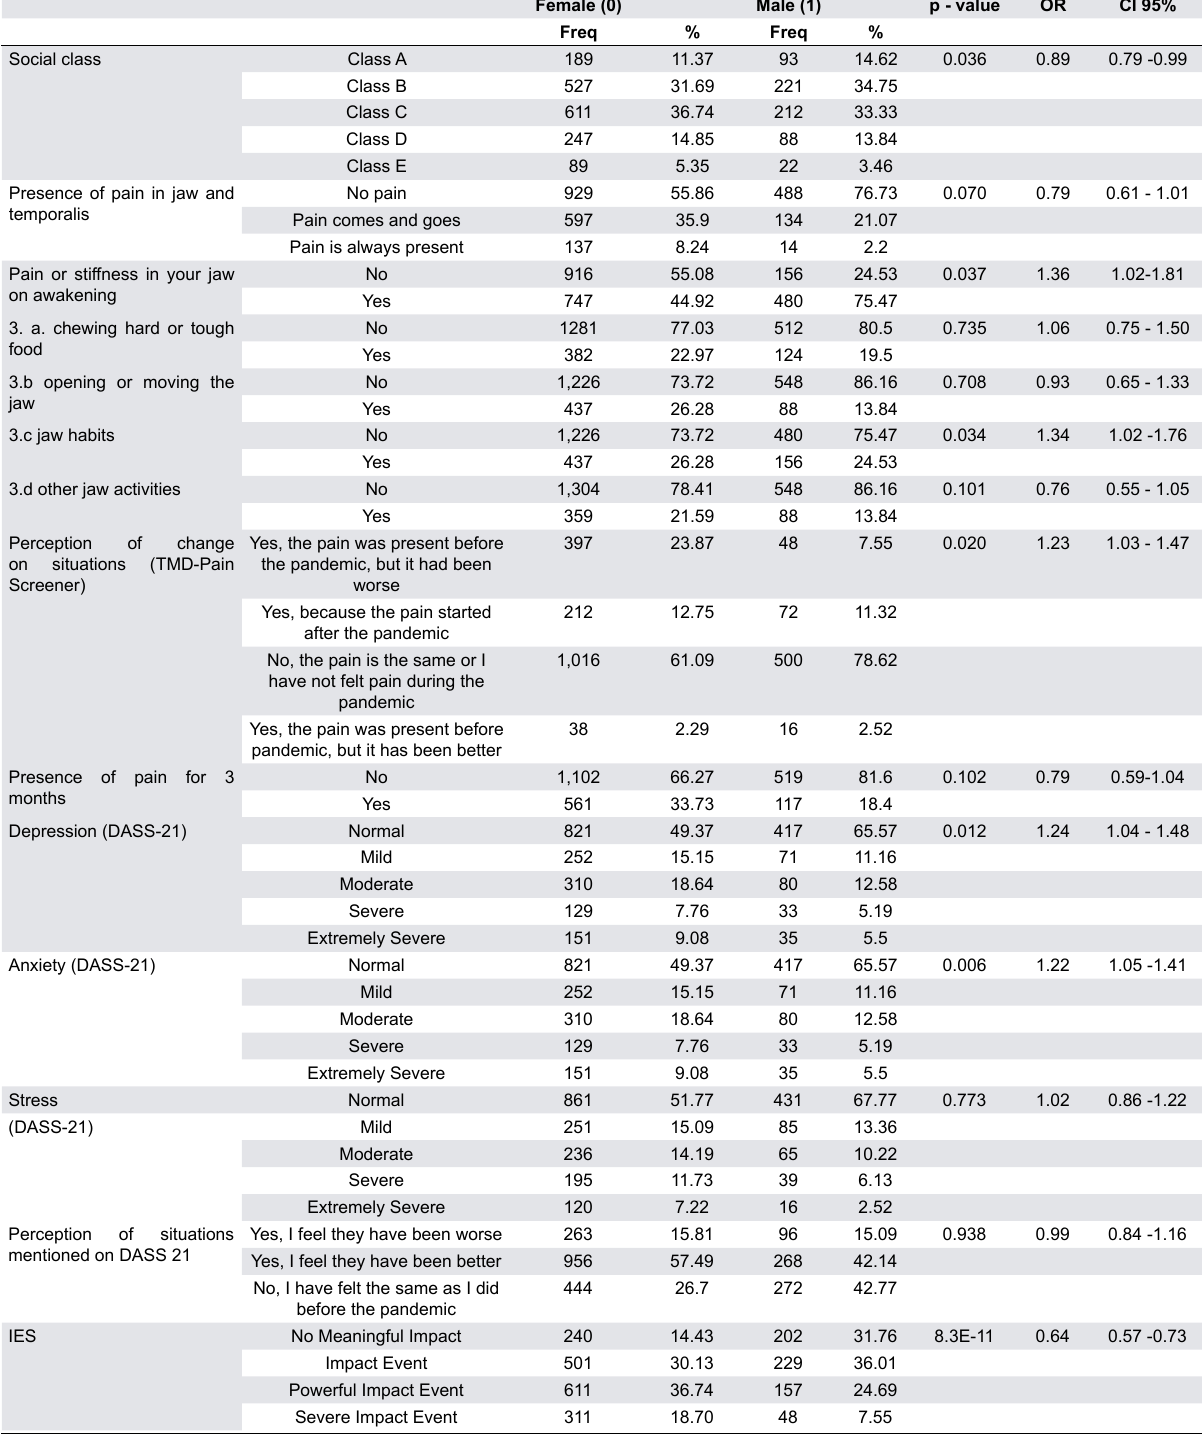
Table 4- Associations between gender and sociodemographic, pain, DASS-21 and IES questionnaires